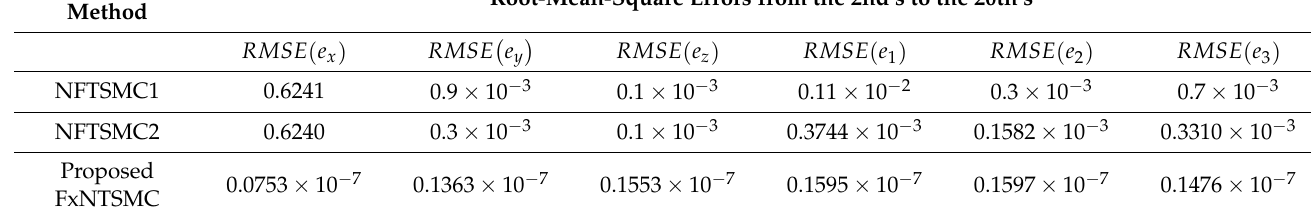
Table 4. Root-mean-square